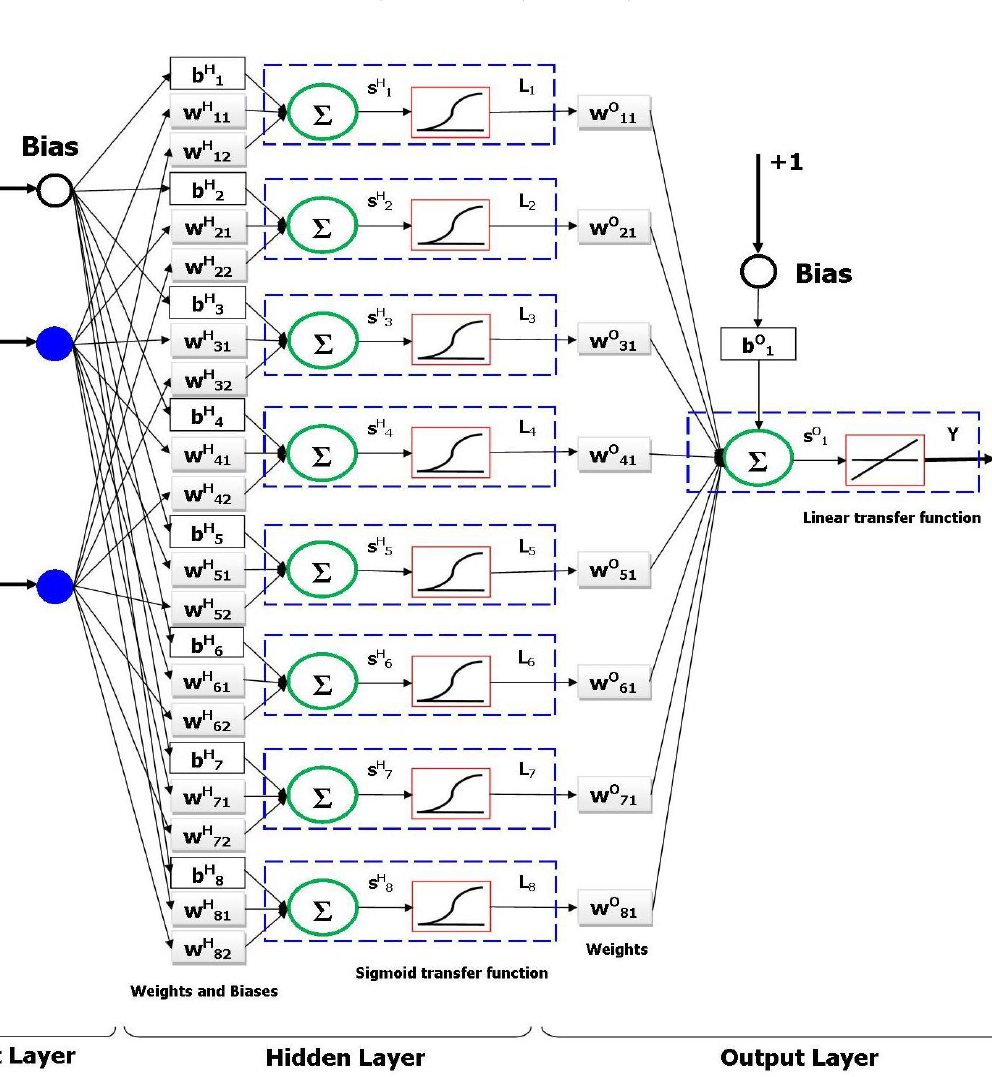
Figure 1. Structure of the proposed three layers feed-forward neural network model.